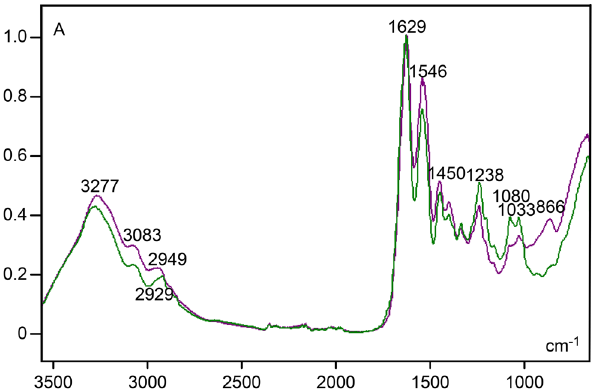
Fig 7. FT-IR spectral profile for dermal CB (purple line) compared to that for collagen type II (green line). A,